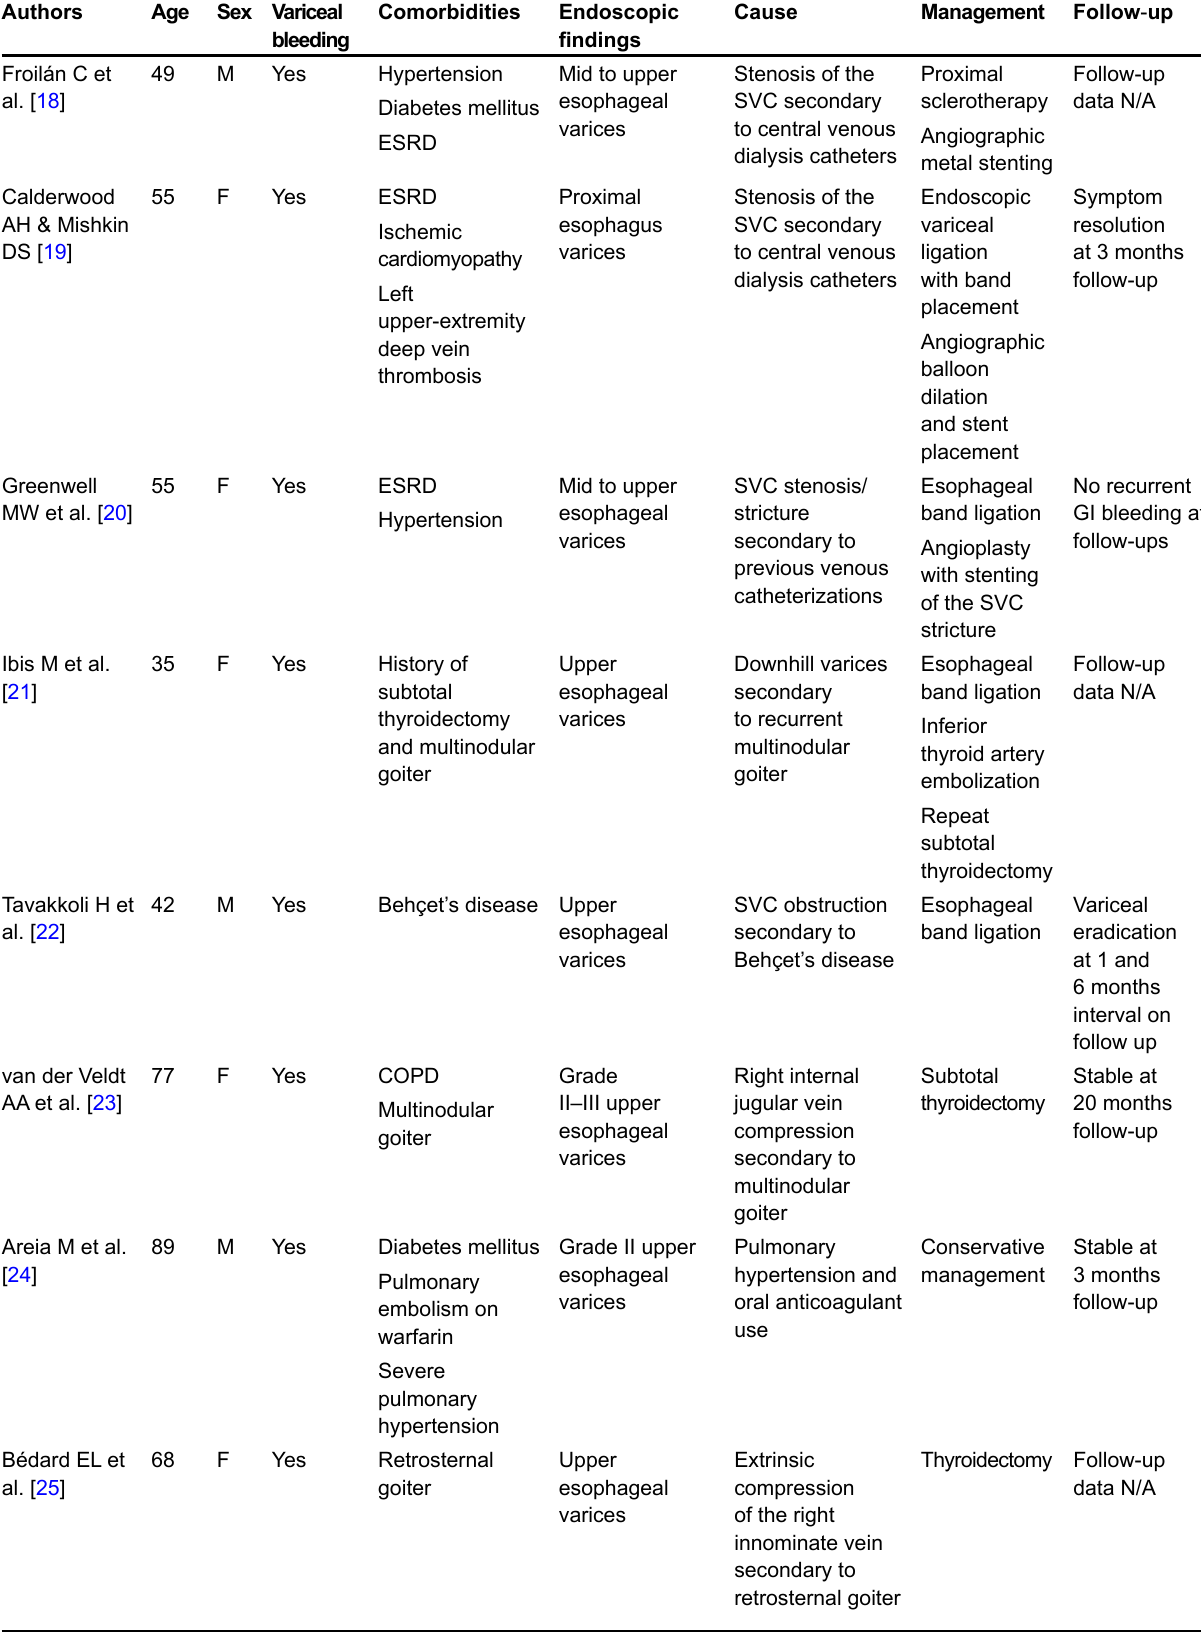
Table 1. Demographics, presentation, causes and management of patients with downhill varices ( continued